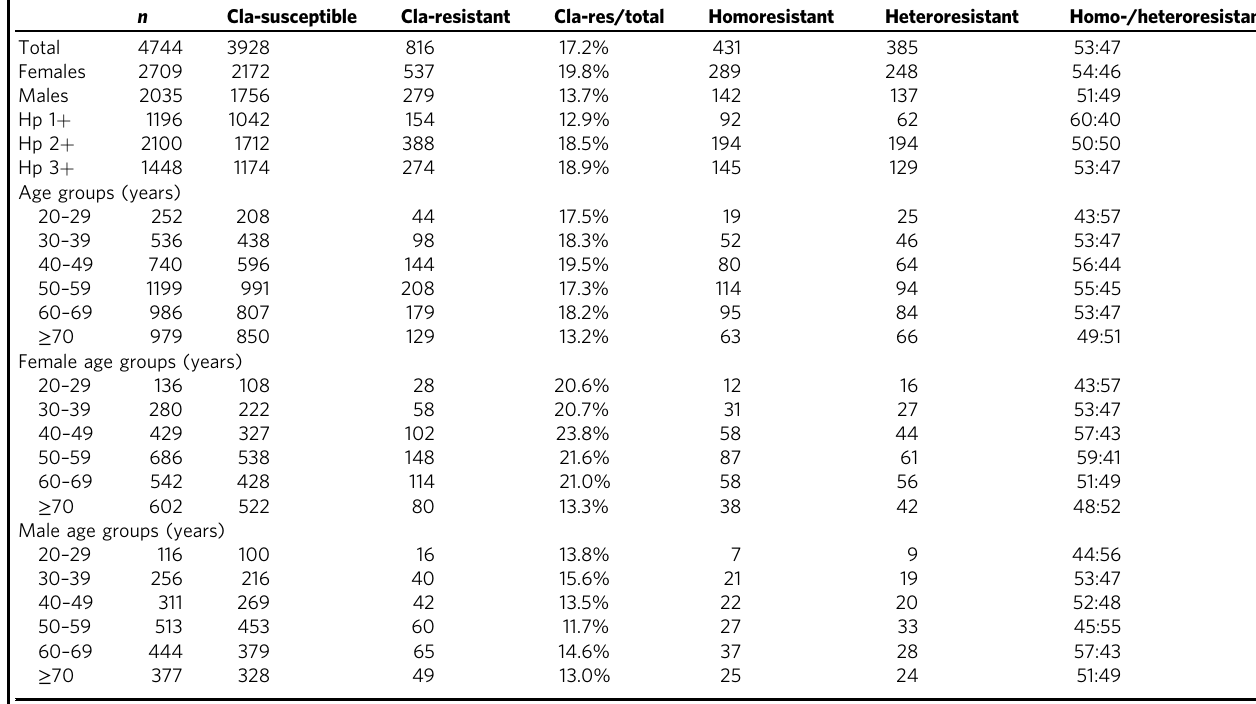
Table 1 Prevalence of clarithromycin-resistant H. pylori infections by sex, bacterial load, and